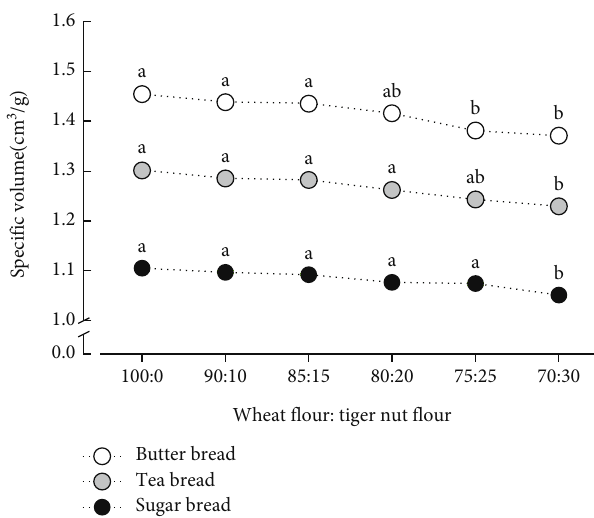
Figure 3: E ff ects of substituting wheat fl our with tiger nut fl our on the speci fi c volume of butter bread, tea bread, and sugar bread. Data points marked by di ff erent letters are signi fi cantly di ff erent at p < 0 : 05